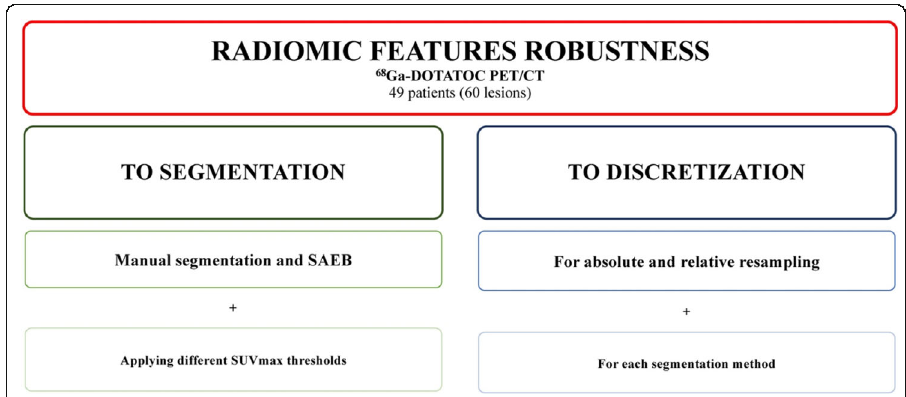
Fig. 2 Flow chart of the ICC and COV L analysis applied to assess radiomic features robustness according to segmentation and